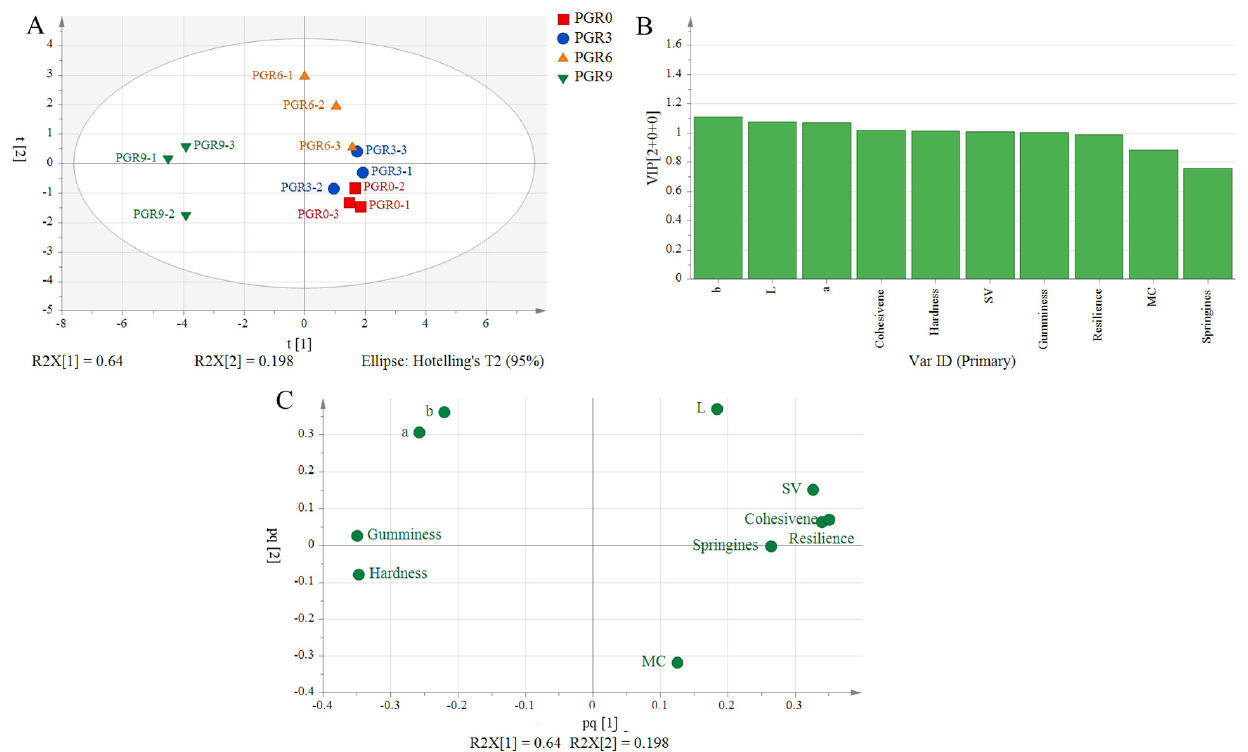
Figure 2. OPLS-DA analysis result. PGR0: without PGR flour; PGR3: with 3 g/100 g PGR Figure 2. OPLS − DA analysis result. PGR0: without PGR fl our; PGR3: with 3 g/100 g PGR fl our; PGR6: with 6 g/100 g PGR flour; PGR9: with 9 g/100 g PGR flour. ( A ): OPLS − DA score plot; ( B ): VIP; ( C ): Loading plot. SV: specific volume; MC: moisture content. Table 1. Parameters of the functions describing viscoelastic properties of dough with different addition amounts of PGR flour.